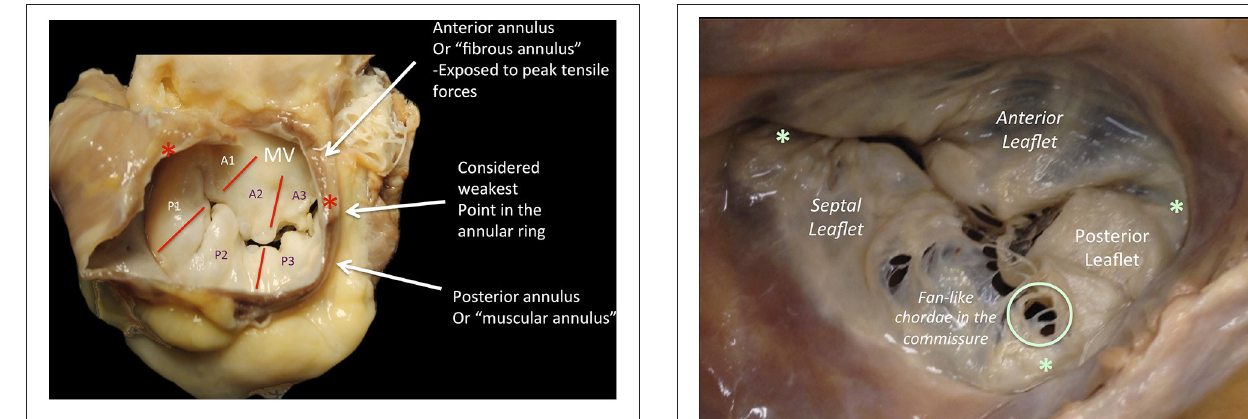
FIGURE 2 | The annulus fibrosus of the mitral is a discontinuous band of connective tissue that exists only in some parts of the attachment of the posterior leaflet, between the two fibrous trigones (red asterisks). The annulus does not exist at the attachment of the anterior leaflet, because the leaflet tissue is continuous with the aorto-mitral curtain that extends from the aortic valve annulus to the base of the anterior leaflet. During the diastole, the shape is grossy circular; during systole it has a saddle shape, with antero-septal diameter significantly smaller than the intercommissural diameter. The anterior leaflet is primarily related to the left ventricular outflow tract via the aorto-mitral curtain, whereas the posterior one is related to the muscular parietal base of the left ventricle. The systolic reduction of the mitral orifice is around 25%, due to the contraction of the base of the heart and the displacement of the aorto-mitral curtain toward the center of the orifice. P1-P3, posterior scallops of the mitral leaflet; A1-A3, anterior scallops; MV, mitral valve; Courtesy of Dr. M. Reisman, University of Washington.